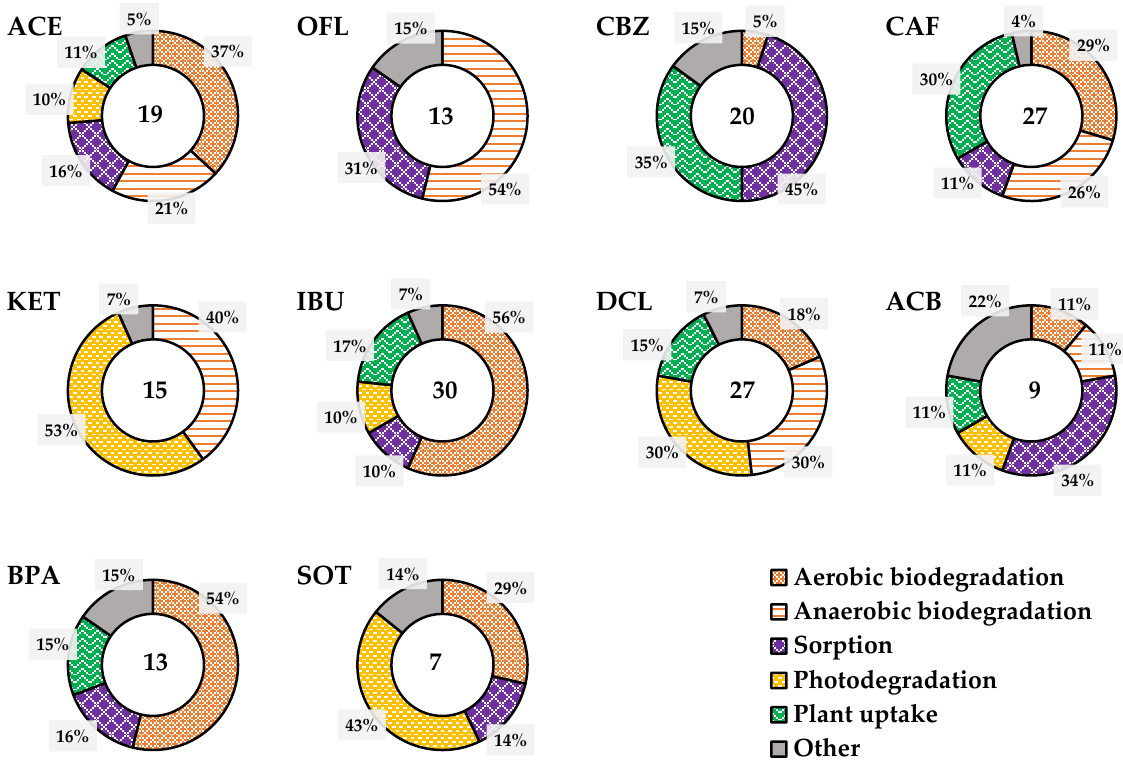
Figure 2. Recurrence of each removal mechanism over the total number of mechanisms (shown inside the pie chart) reported in the reviewed papers on the removal of each EOC in CW (For acronyms, see Table 1. Detailed information is given in Table S1).